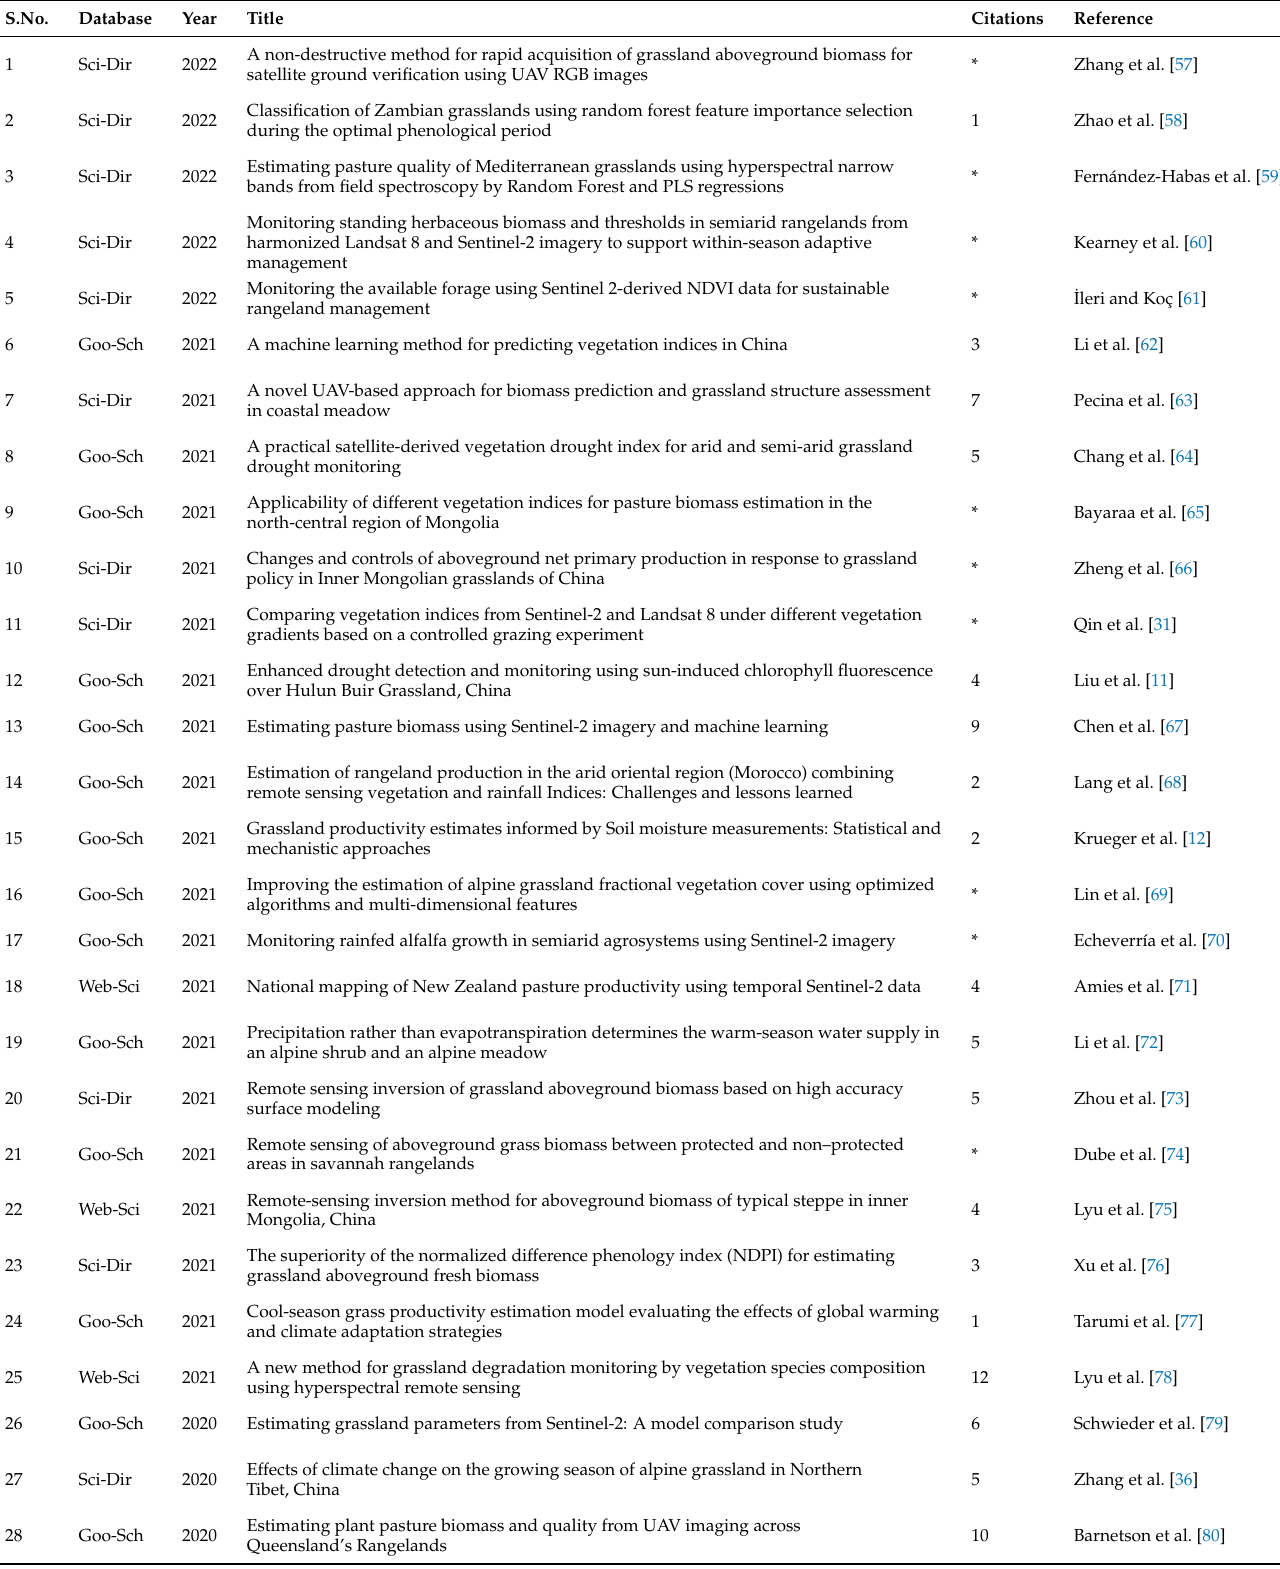
Table A1. Details of selected articles through systematic literature review and their citation